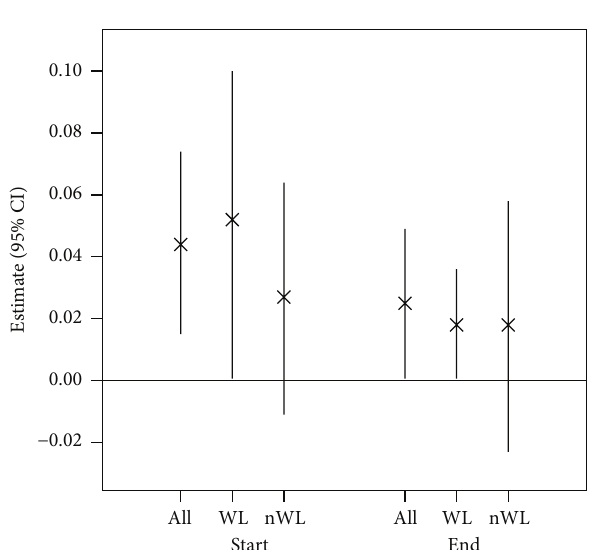
Figure 2: Estimates (95% CI) for associations of tyrosine with HOMA. Associations were calculated at baseline (Start) and after the intervention (End). Associations were calculated for all obese children ( 𝑛 = 80 ), children with substantial weight loss (WL, 𝑛 = 40 ), and children without substantial weight loss (nWL, 𝑛 = 40 ). 95% CI: 95% confidence